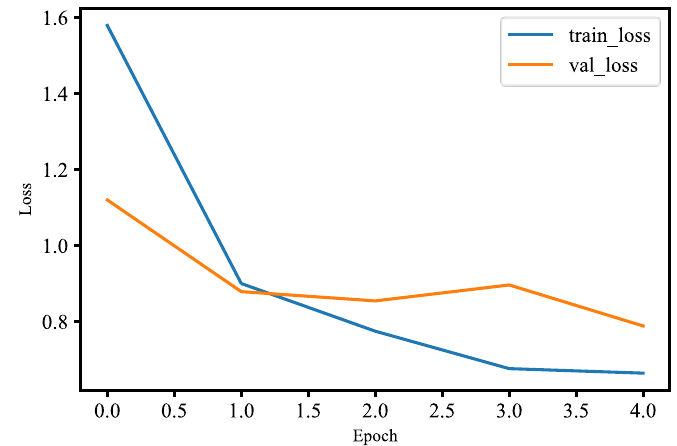
Figure 37. Loss of human face detection.